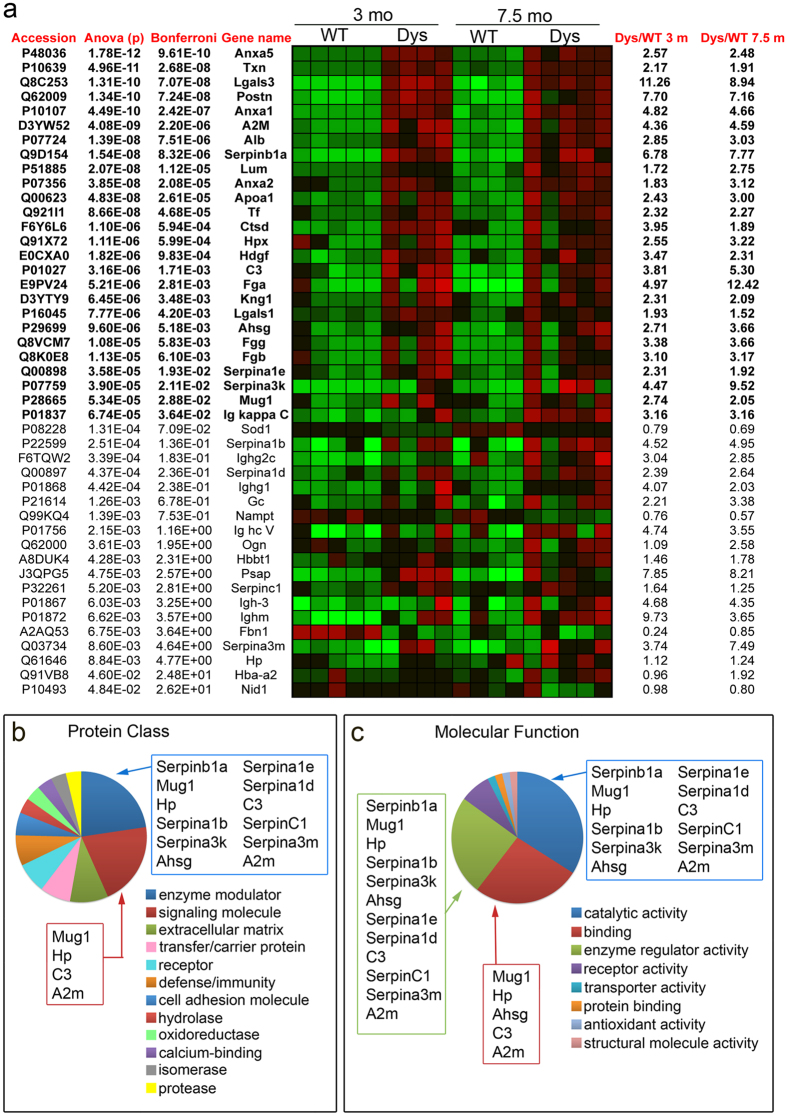
Detection of extracellular proteins in dystrophic muscle.(a) List of significantly different extracellular proteins organized by increasing p-value (decreasing statistical significance). Red is increased abundance, green is decreased abundance compared to the average abundance across all data-points (both ages and both genotypes) for each protein. WT = wild type, Dys = dystrophic (mdx4cv). (b) Mapping of differentially abundant extracellular proteins to Protein class using the functional annotation tool PANTHER (http://www.pantherdb.org/) reveals enrichment in enzyme modulators and signaling proteins, both classes including several serine protease inhibitors. (c) Mapping of differentially abundant extracellular proteins to Molecular function using the functional annotation tool PANTHER confirms the enrichment in serine protease inhibitors.